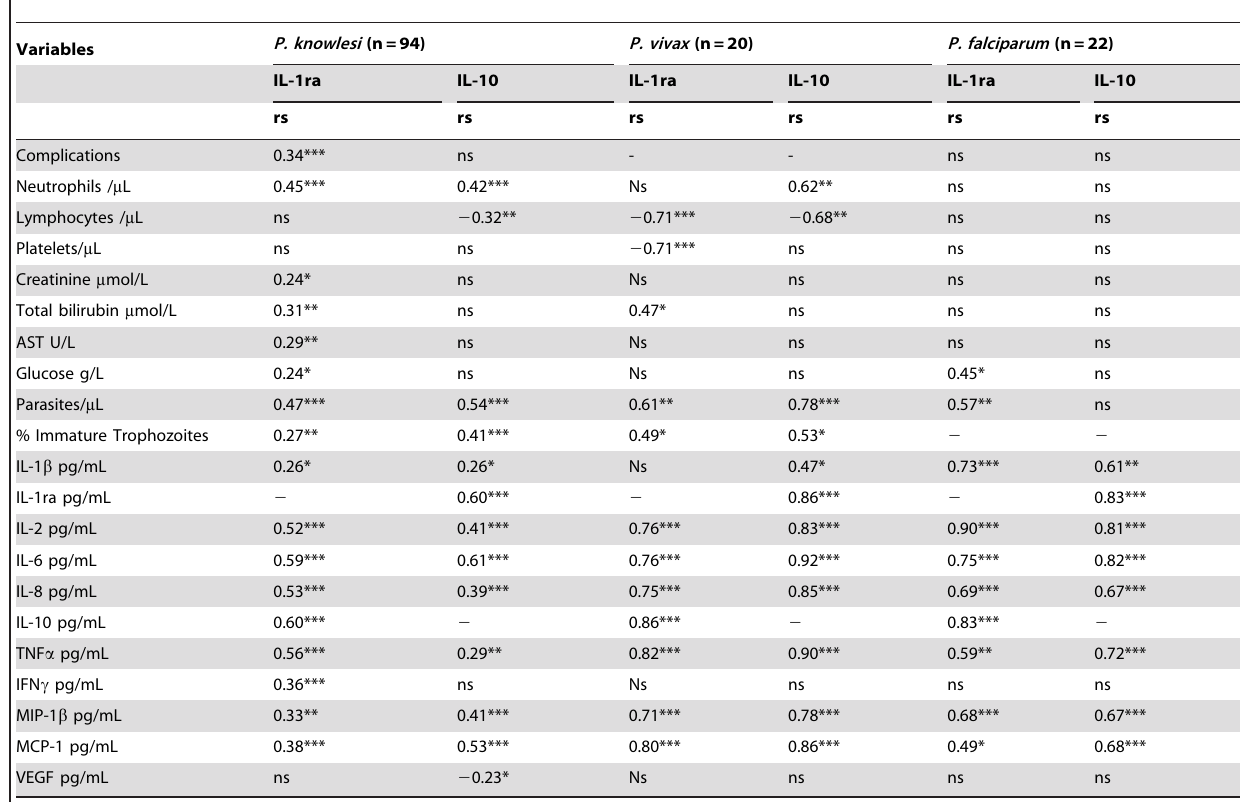
Table 3. Associations between variables measured, IL-1ra and